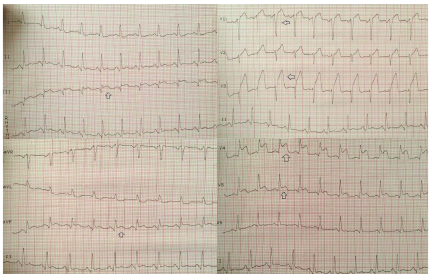
Figure 3: ST segment elevations in both inferior and precordial leads after fibrinolytic therapy.